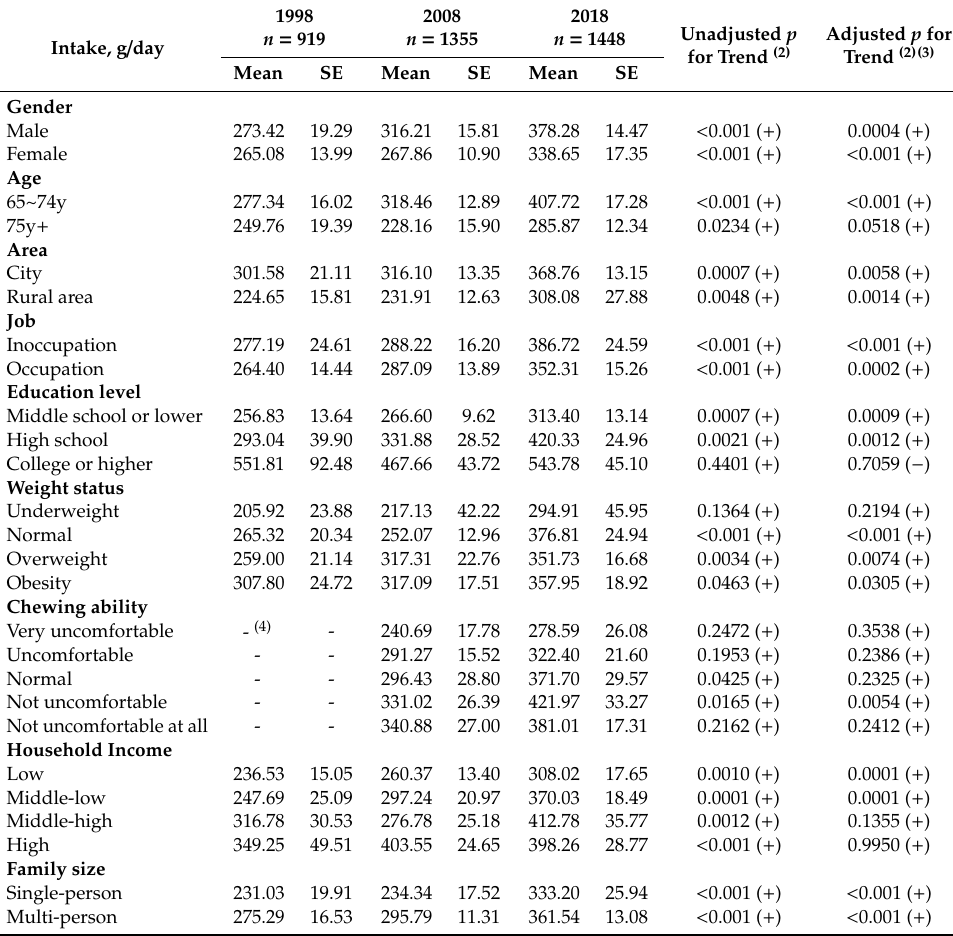
Table 3. Fruits & vegetable intake (1) according to survey year by general